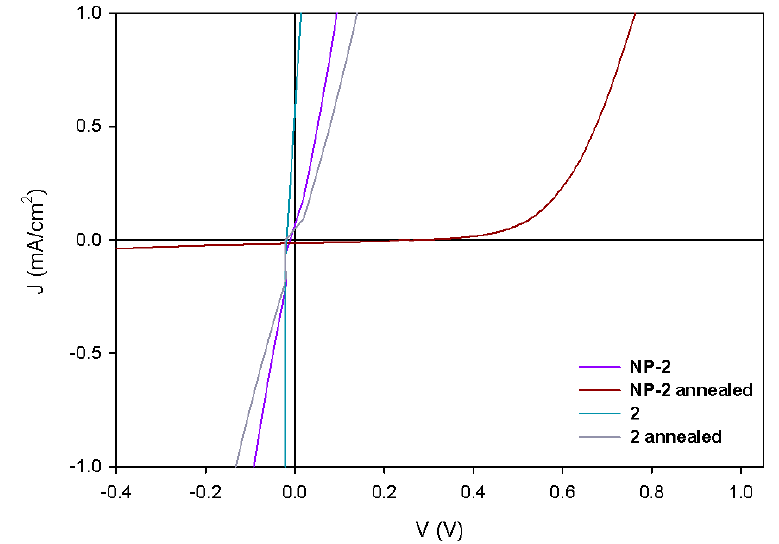
Figure S3. I-V curves of unannealed and annealed devices prepared with 2 and NP2 with